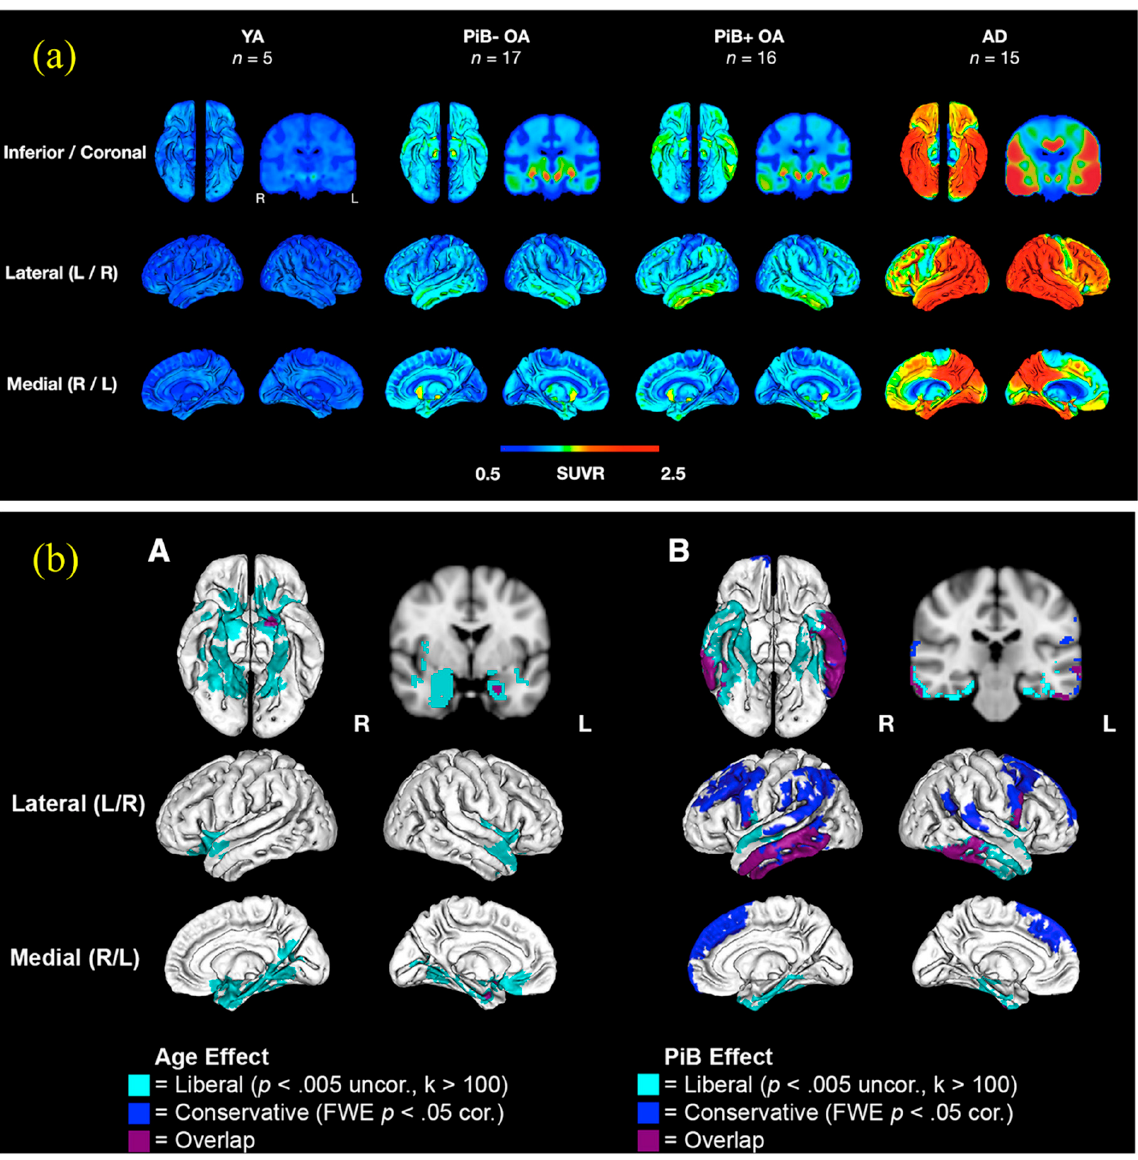
Figure 8. ( a , b ) in vivo PET spatial range of AV-1451 retention correlated with age, A β , and tau. (Adapted with permission from [233], Cell Press, 2016).